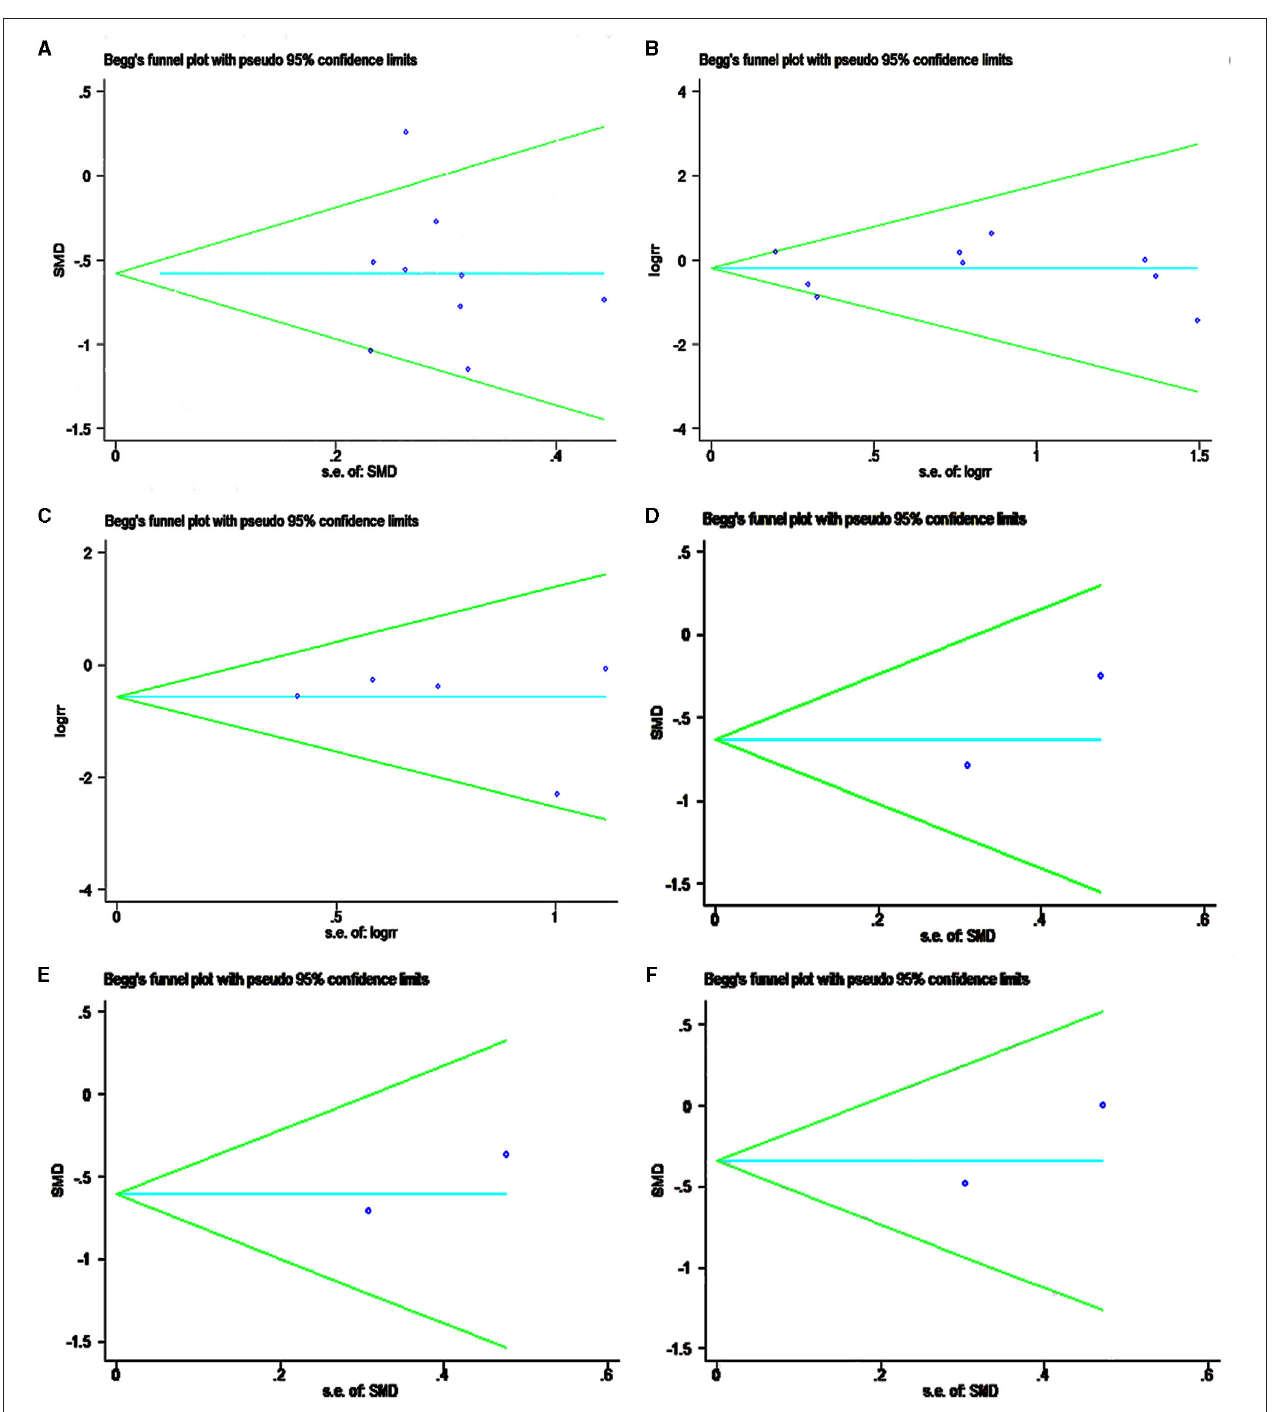
FIGURE 5 | Funnel plot showing the meta-analysis of publication bias recognition. (A) CMS; (B) complications; (C) reoperation rate; (D) SST; (E) ASES; (F) SF-12V2.